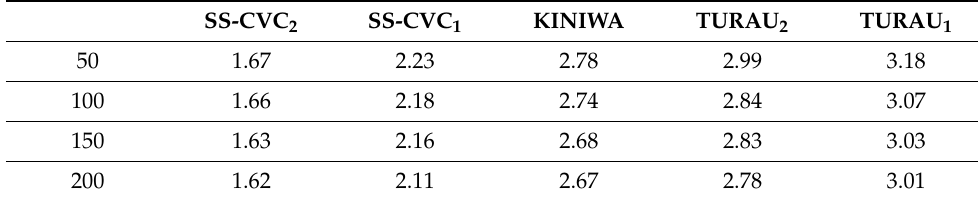
Table 3. Approximation ratios of algorithms (Avg. degree =